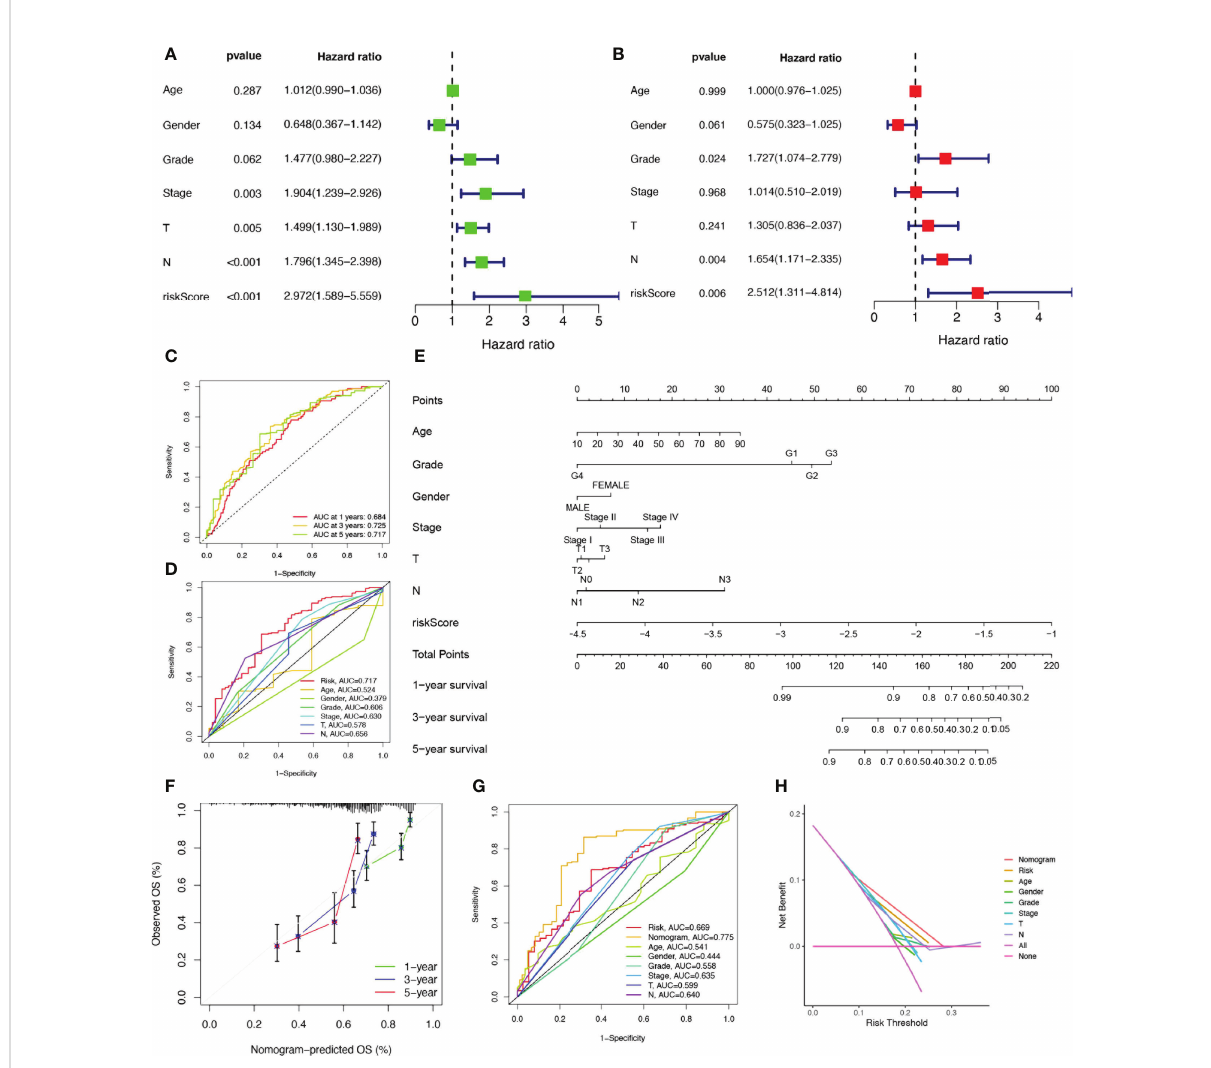
FIGURE 4 Establishment of nomograms in combination with clinical characteristics. (A) Univariate and (B) multivariate COX regression analysis of the signature and different clinical feature. (C) Time-dependent ROC curves analysis. (D) Multi-index ROC analysis (E) Nomogram for predicting 1, 3, and 5-year OS of patients with HNSCC. (F) The calibration curve of the constructed nomogram of 1, 3, and 5-year survival. (G) The nomogram ’ s time-dependent ROC curves. (H) Decision curve